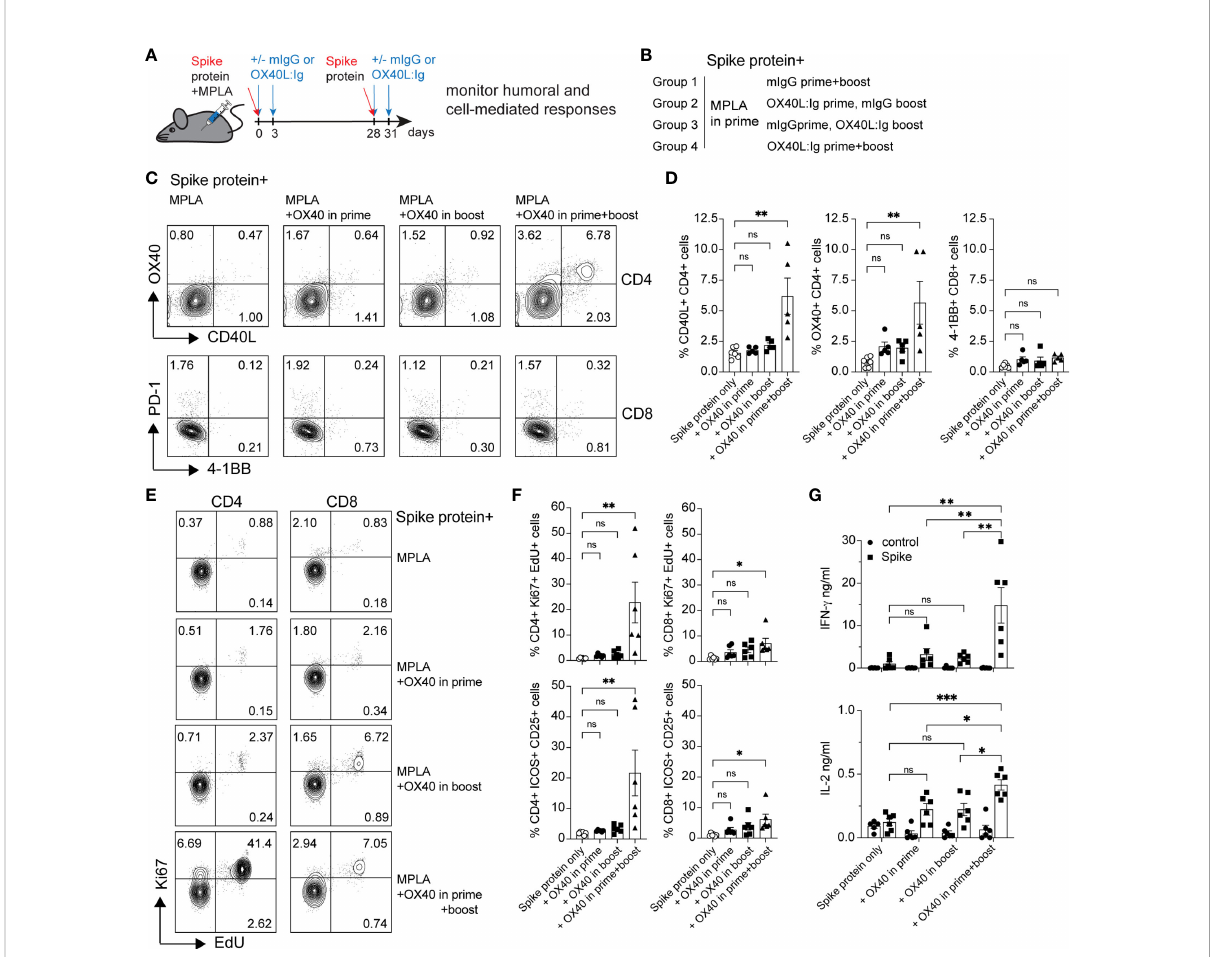
FIGURE 1 OX40 agonist enhances CD4 and CD8 antigen-speci fi c T cell immunity to spike protein vaccination. Groups of mice were immunized with the SARS-CoV-2 spike protein emulsi fi ed in Montanide ISA 51 and MPLA (present in the prime), with mouse IgG (mIgG) or with OX40L:Ig injection in the prime, in the boost or both. Cells were isolated from the blood at 10 weeks post-immunization and cultured in the presence of recombinant spike protein. (A) Schematic representation of immunization with the spike protein and timing of the OX40L:Ig injections. (B) Description of the experimental group layout. (C) Expression of OX40 and CD40L on CD4 T cells (top) and PD-1 and 4-1BB on CD8 T cells (bottom) by fl ow cytometry after overnight incubation (16 hrs) with the spike protein. The dot plots shown are from representative mice in each group. Numbers in each quadrant indicate percent positive cells. (D) Summary of CD40L- and OX40-expressing CD4 T cells and 4-1BB- expressing CD8 T cells in all experimental groups. (E) Cells were cultured for 3 days in presence of antigen and EdU was added for 18 hrs to reveal replicating cells. Numbers in each quadrant indicate percent positive cells. (F) Ki67 expression and EdU incorporation (top panels) and ICOS/CD25 expression (bottom panels) were analyzed to assess T cell proliferation and activation in CD4 and CD8 T cells in all groups. (G) Supernatants of the 3-day cultures (blood) were assessed for the presence of IFN- g and IL-2 in absence or presence of spike protein. N=6 animals per group, 1 of 2 experiments is shown. Each individual symbol in the bar graphs represents a single mouse. In D , F and G , bars indicate mean ± SEM. One-way ANOVA with Tukey ’ s multiple-comparisons test. *P<0.05, **P<0.01, ***P<0.001, ns, not signi fi